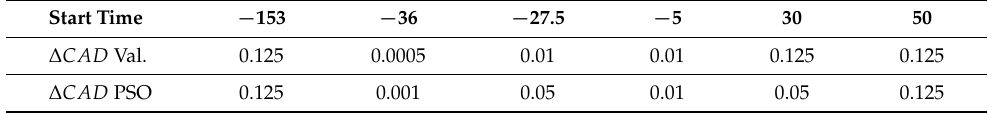
Table 4. Time discretization for the validation and PSO